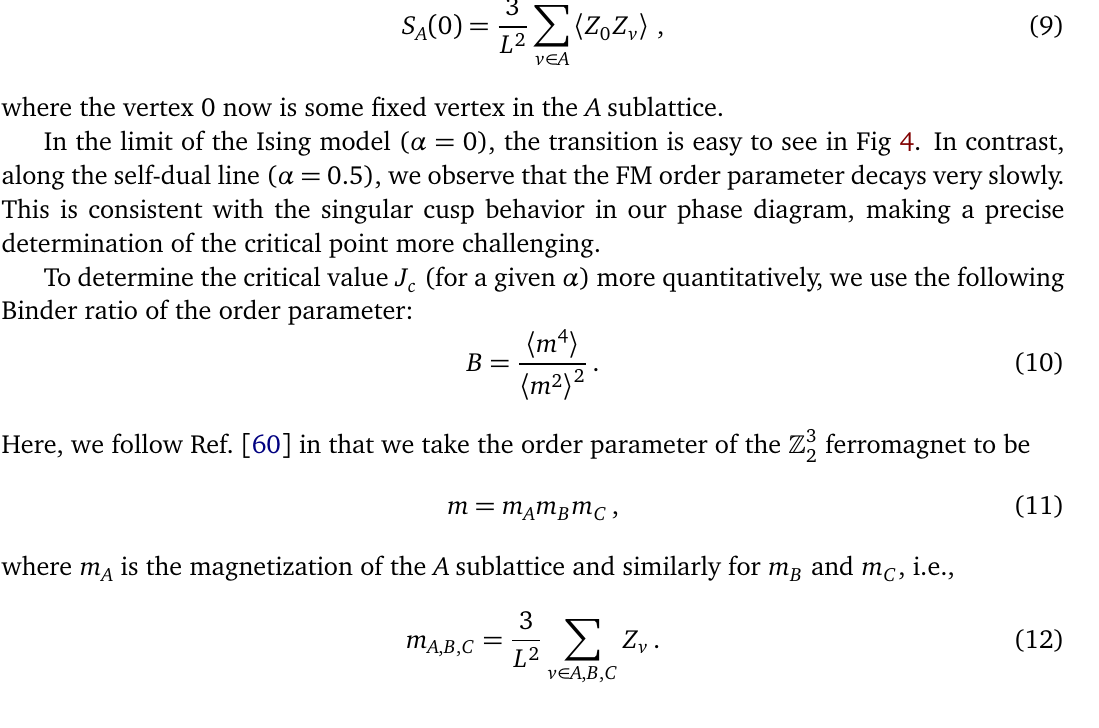
Figure 4: The structure factor at k = 0 for the A sublattice of the L × L triangular lattice, which is an order parameter for the ferromagnetic phase ( S transition is seen for α = 0, corresponding to Ising 3 criticality. In contrast, the order parameter decays very slowly for α = 0.5, meaning that it has a small value over a wider region of parameter space, making it more challenging to precisely locate the critical point. This region with a small magnetic moment is consistent with the phase boundary in Fig. 2 displaying a narrow ordered region upon approaching the multicritical point. In fact, the latter seems to end in a cusp, which is expected from SO ( 5 ) deconfined criticality (see also Fig.